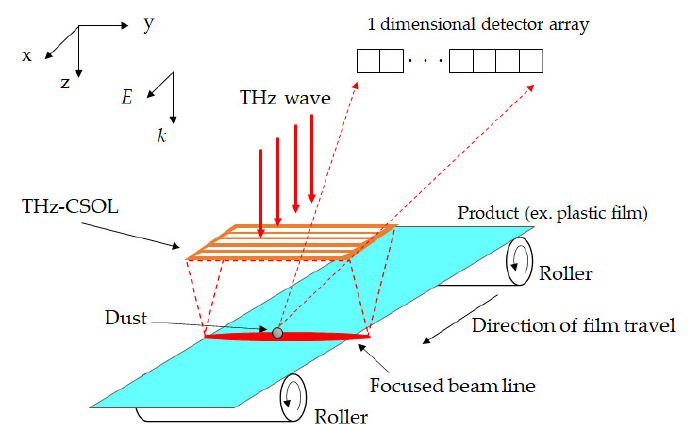
Figure 1. Schematic illustration of product inspection with THz cylindrical super-oscillatory lens (THz-CSOL). The propagation direction k and polarization direction E of the THz wave are parallel to the z and x axes, respectively. (Not drawn to scale.).